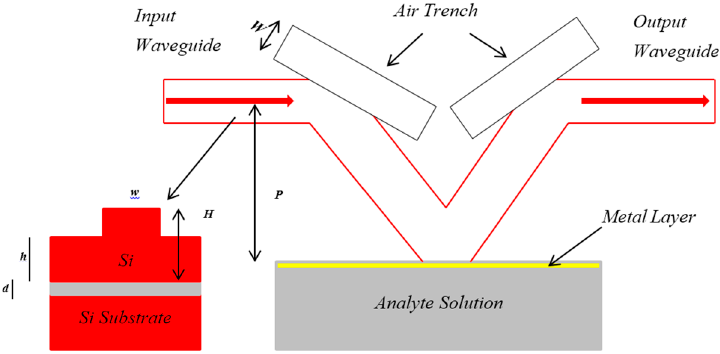
Figure 3. A view of the top of an optical rib waveguide array-based surface plasmon resonance sensor and the identical cross-section of a SOI rib waveguide.